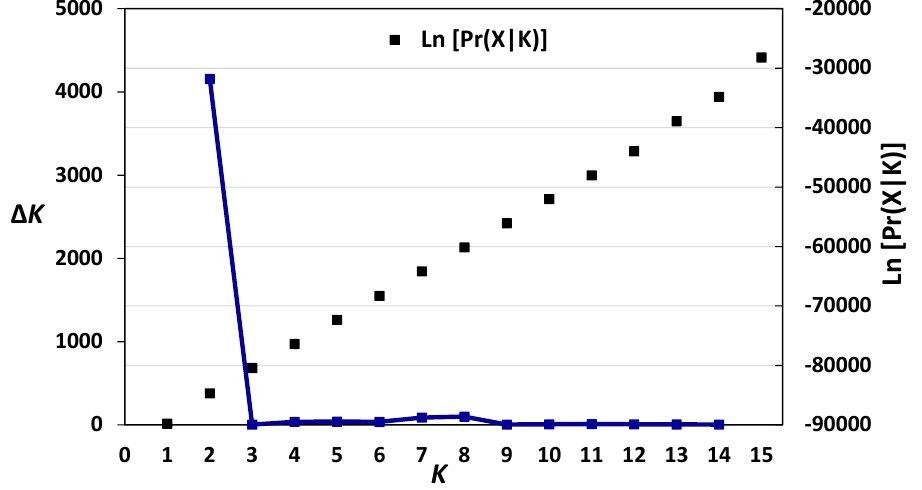
Figure 7. Analysis of population structure of 618 European wheat genotypes based on the 141 common DArT markers, the log-likelihood and Δ K values based on the change rate of log-likelihood function between successive K [41].